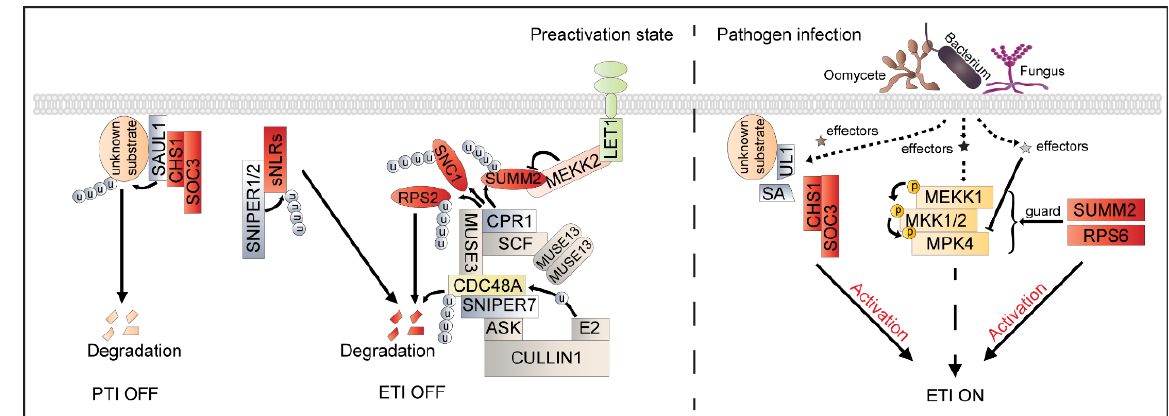
Figure 2. A working model of the ubiquitination regulation of NLR homeostasis. Under normal conditions, a potential unknown substrate is ubiquitinated by the E3 ligase SAUL1, which leads to the degradation of SAUL1 ′ s substrate and deactivates PTI. In addition, SAUL1 associates with the NLR pairs SOC3–CHS1 and is required for SOC3-mediated immune activation. Another E3 ligase, SCFCPR1, interacts with SNC1, RPS2, and SUMM2 and contributes to their ubiquitination and degradation. The TRAF protein MUSE13 homodimerizes and heterodimerizes with NLRs and SCFCPR1 to facilitate SNC1 and RPS2 turnover. The E4 ligase MUSE3 associates with SNC1 and promotes efficient elongation of the ubiquitin chain in NLRs. AAA–ATPase CDC48A interacts with MUSE3 and contributes to the NLR polyubiquitination process. In contrast, the SCFSNIPER7 complex regulates unfoldase CDC48A protein turnover and modulates immune output. MEKK2 scaffolds RLK LET1, which stabilizes SUMM2, and counter-regulates SCFCPR1-mediated SUMM2 ubiquitination. SNIPER1 and its homolog SNIPER2 globally control the protein levels of sNLRs for the immediate attenuation of immune output to effectively avoid autoimmunity. When plants are challenged with an incompatible pathogen carrying an unknown effector that specifically targets SAUL1, SAUL1 is inactivated, leading to the accumulation of the SAUL substrate, which represses PTI. Meanwhile, the inactivation of SAUL1 results in the constitutive activation of SOC3, triggering strong ETI. The effectors induce MEKK1–MKK1/MKK2–MPK4 cascade activation. However, some effectors may disrupt the MEKK1–MKK1/MKK2–MPK4 cascade, leading to CNL SUMM2 and TNL RPS6 activation and intensive activation of the ETI response.